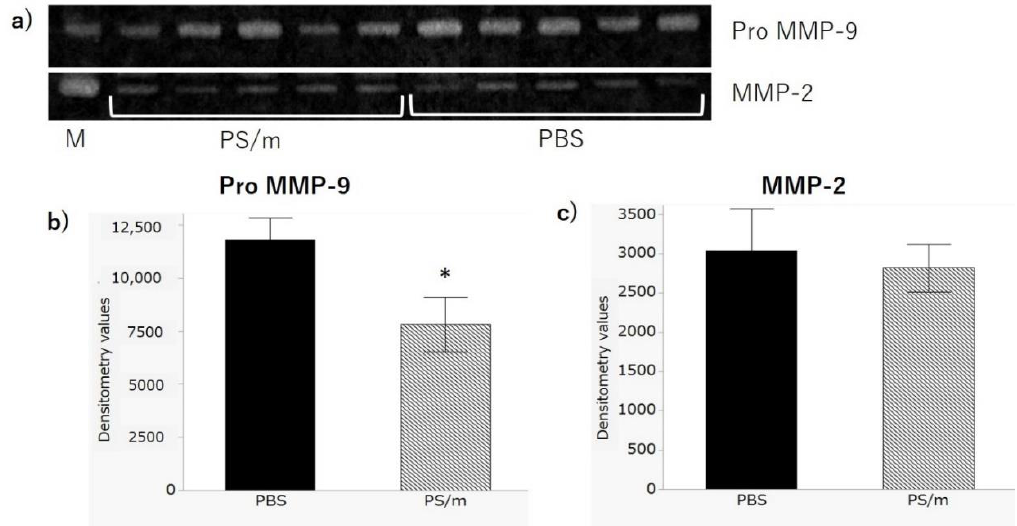
Figure 5. Gelatin zymography of AAA lysates. ( a ) Image of gelatin zymography. Upper bands (92 kDa) represent pro-matrix metalloproteinase (MMP)-9, and lower bunds (64 kDa) represent MMP-2. Samples are the AAAs of rats treated with PBS ( n = 5) and PS/m 5 mg/kg ( n = 5). MMP marker was applied in the left lane (M). ( b ) Gelatinase activity of pro-MMP-9. The activity of the group treated with PBS was significantly higher than the group treated with PS/m. ( c ) Gelatinase activity of MMP-2. There was no significant difference between the groups. * p < 0.05. Error bars denote the standard error of the mean.